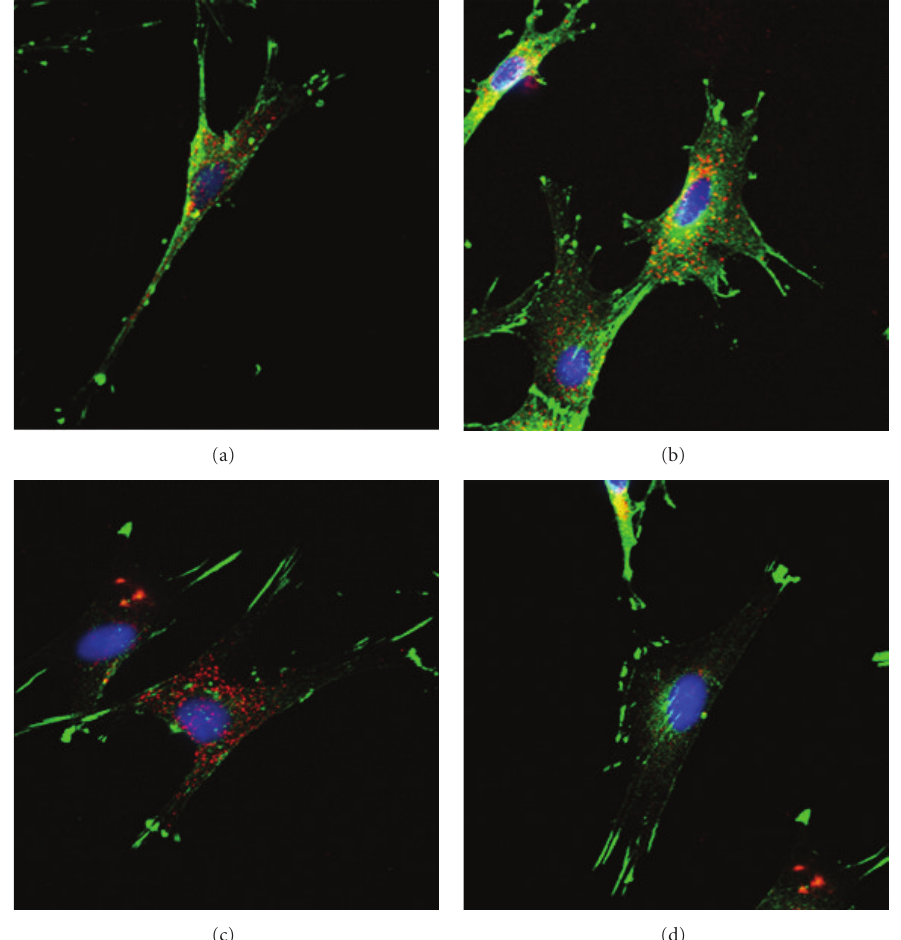
Figure 5: Actin and Vinculin expression of osteoblasts in the presence of LiHA. Magnification 1000x. (a) 0.25% LiHA at 900 ◦ C, (b) 0.25% LiHA at 1300 ◦ C, (c) 2.00% LiHA at 900 ◦ C, and (d) 2.00% LiHA 1300 ◦